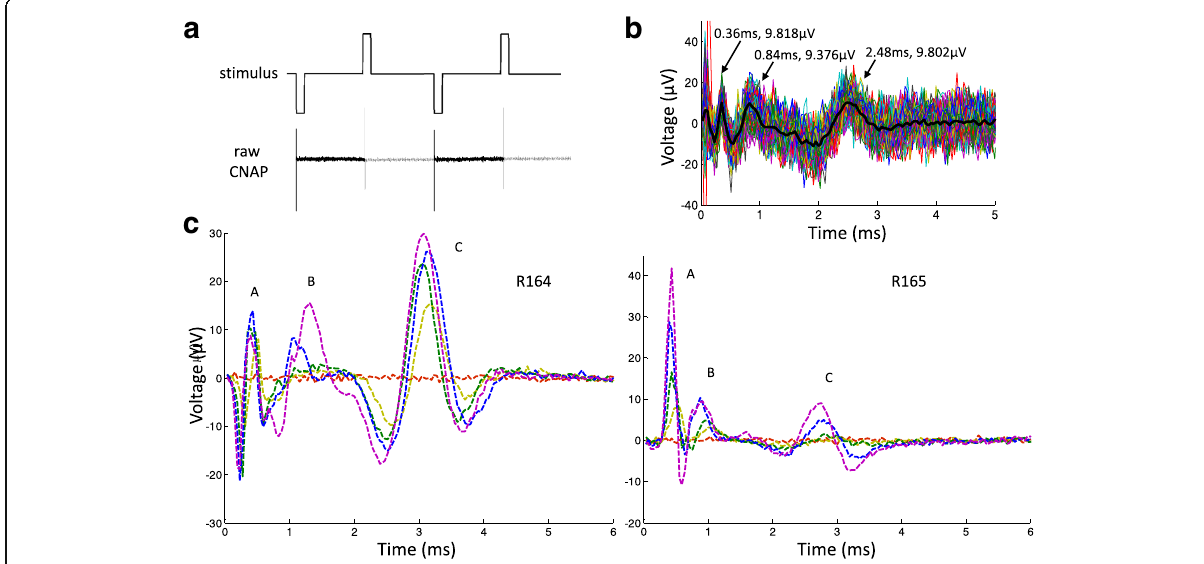
Fig. 1 Vagal nerve response to stimulus. a Sample stimulus waveform (not to scale) and raw vagal recording. The darker segment of the recording represents the signal during the cathodic phase; the lighter segment represents the signal during the identical anodic phase half a period later. Two periods of alternating phases are shown. The spikes are due to stimulus artifacts, whose magnitudes were on the order of mV to V, depending on the stimulus intensity. b Sample processed CNAP. Summing the cathodic phase with the anodic eliminated the artifact. The summed segments (dotted traces) were then averaged to produce the estimated CNAP (thick, solid trace) for the trial. The three prominent peaks are labeled. c Sample CNAP series from the same stimulus waveform at different current amplitudes. As current increased, the peak heights (magnitude on the order of μ V) increased as well. Peak designations are annotated. Data from two animals (R164 and R165) are presented to demonstrate variations in CNAP